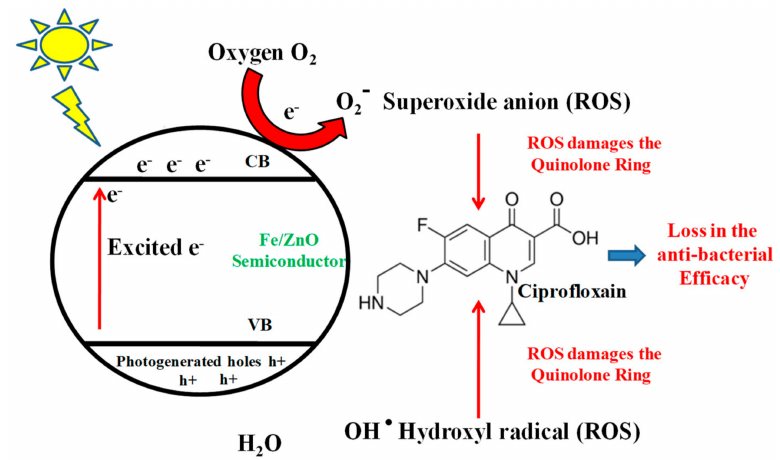
Figure 1. Schematic representation showing generation of reactive oxygen species (ROS) by Fe ZnO nanoparticles on activation with sunlight, and how these ROS attack active components of FQ to degrade them and reduce their anti-bacterial